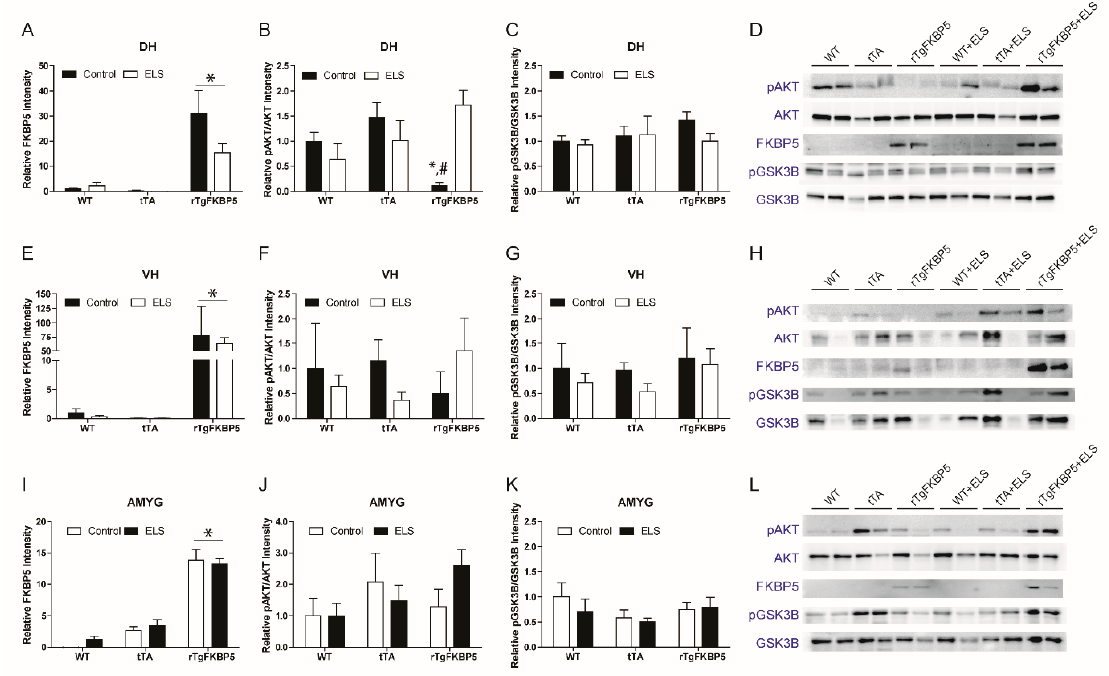
Figure 5. Overexpression of FKBP5 reduces pAKT / AKT ratio in the dorsal hippocampus. ( A ) FKBP5 protein expression from DH tissue punches normalized to total protein. Calculated ratio of ( B ) pAKT / AKT and ( C ) pGSK3 β / GSK3 β in DH. ( D ) Representative Western blots for DH. Protein expression calculated for ( E ) FKBP5, ( F ) pAKT / AKT and ( G ) pGSK3 β / GSK3 β ratios in the VH. ( H ) Representative Western blots for VH. Tissue punches were also extracted from the AMYG to assess protein expression of ( I ) FKBP5 followed by ( J ) pAKT / AKT and ( K ) pGSK3 β / GSK3 β in this structure. ( L ) Representative Western blots for AMYG. Interaction of stress and genotype was analyzed by two-way ANOVA followed by Bonferroni correction when significant * = p < 0.05.; # = significant difference between stressed and non-stressed rTgFKBP5 mice. Values are represented as standard error of the mean (SEM) and protein was normalized to total protein expression. DH = dorsal hippocampus, VH= ventral hippocampus, AMYG = amygdala, ELS = early life stress.